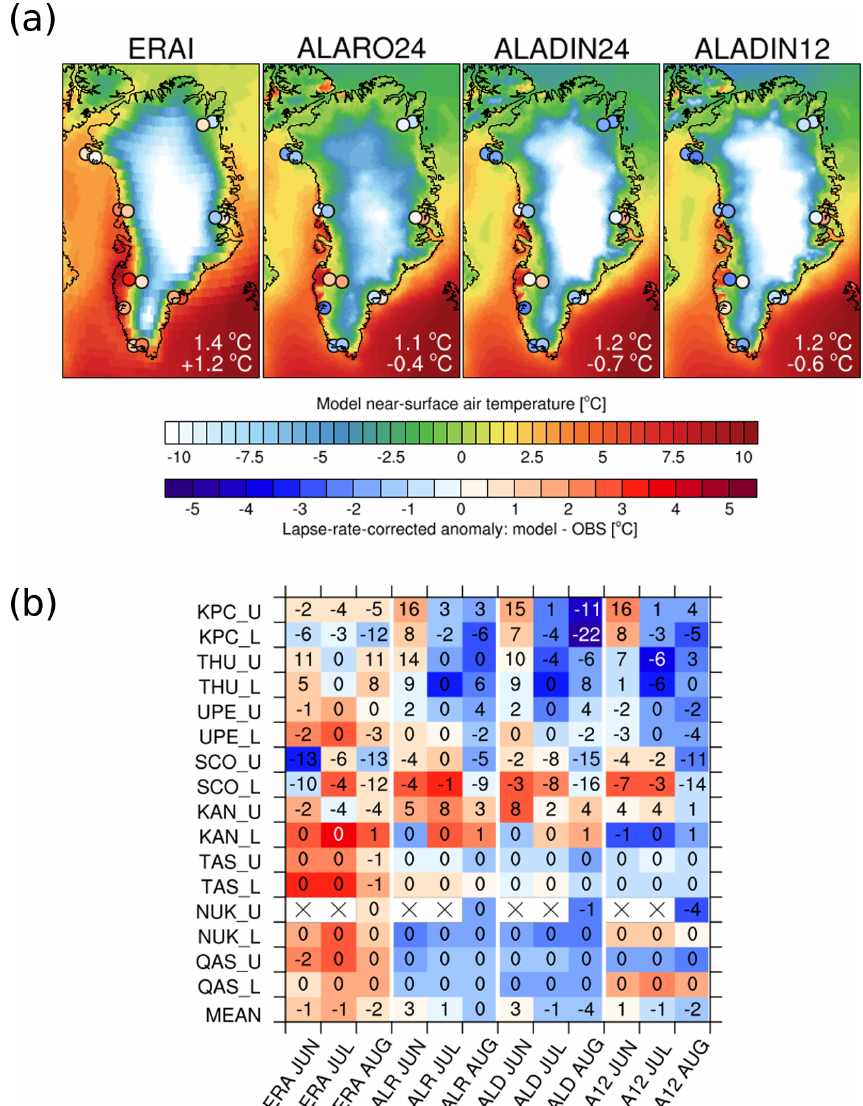
Figure 8. (a) The summer (JJA) mean temperature from ERA-Interim compared to the three HCLIM38 experiments. Coloured dots indicate the anomalies between the lapse-rate-corrected model temperature and the observation at each PROMICE station. Numbers in the lower right corner indicate the root mean square error (top) and the average anomaly across the stations (bottom). (b) The monthly mean difference between the simulated lapse-rate-corrected temperature and the observations at each PROMICE station. The shading corresponds to the anomaly shading in (a) , while the number indicates the anomaly in the number of melt days between the model and observations (ordered by latitude, north to south). Negative (positive) numbers indicate that the model has too few (too many) melt days compared to observations. Crosses on a white background indicate missing observational data. Model names have been shortened: ERA is ERA-Interim, ALR is ALARO24, ALD is ALADIN24 and A12 is